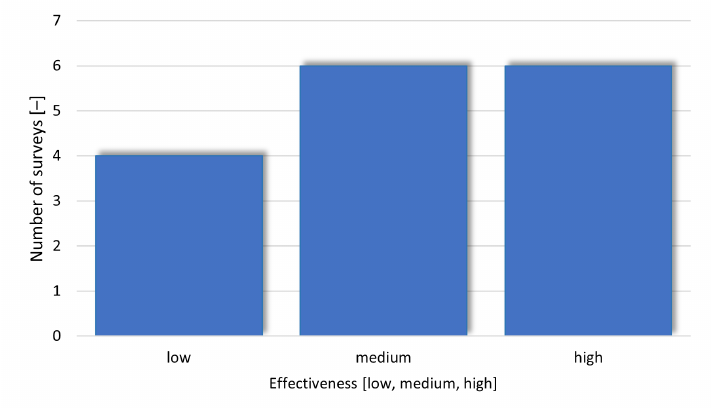
Figure 12. The number of surveys depending on the ODS effectiveness. Almost the same number of low, medium, and high-efficiency solutions proves the constant development of